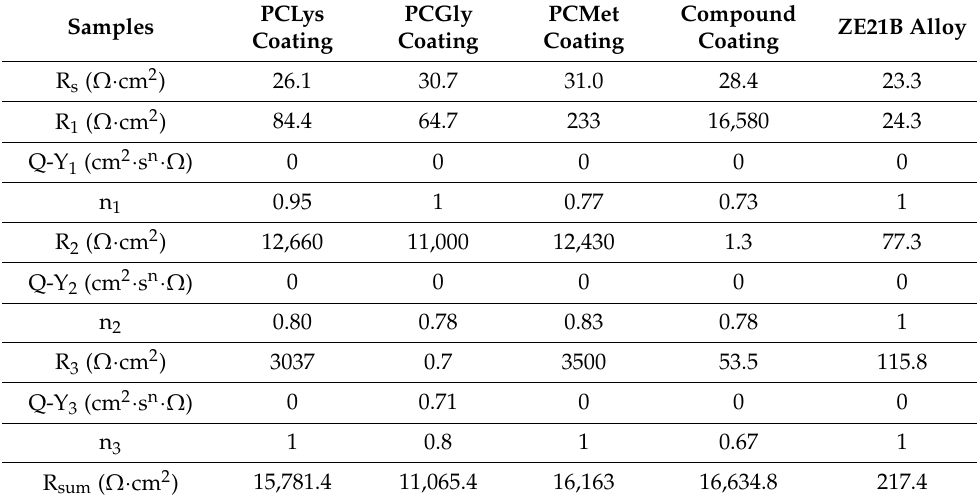
Table 5. Equivalent circuit fitting parameters.